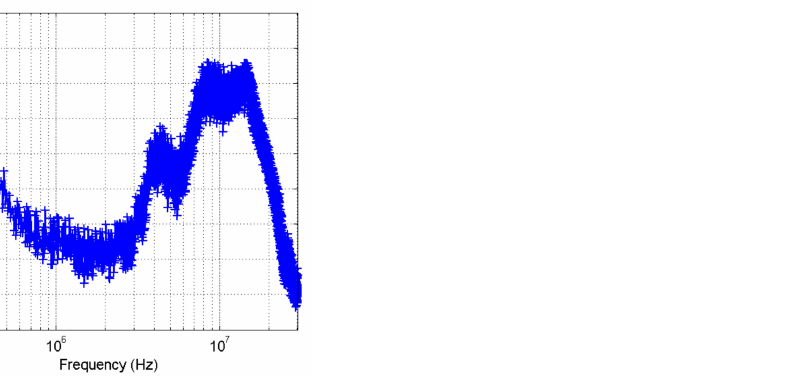
Figure 7. Testing for the conducted EMI. Measurement results for the motor loaded with the rated torque, with no PWM modulation, at the speed of n = 5000 rpm, with the input EMC filter. Speed controlled by adjustment of the RMS value of the AC voltage feeding drive. Adding an EMC filter reduces the noise to the standard accepted levels.